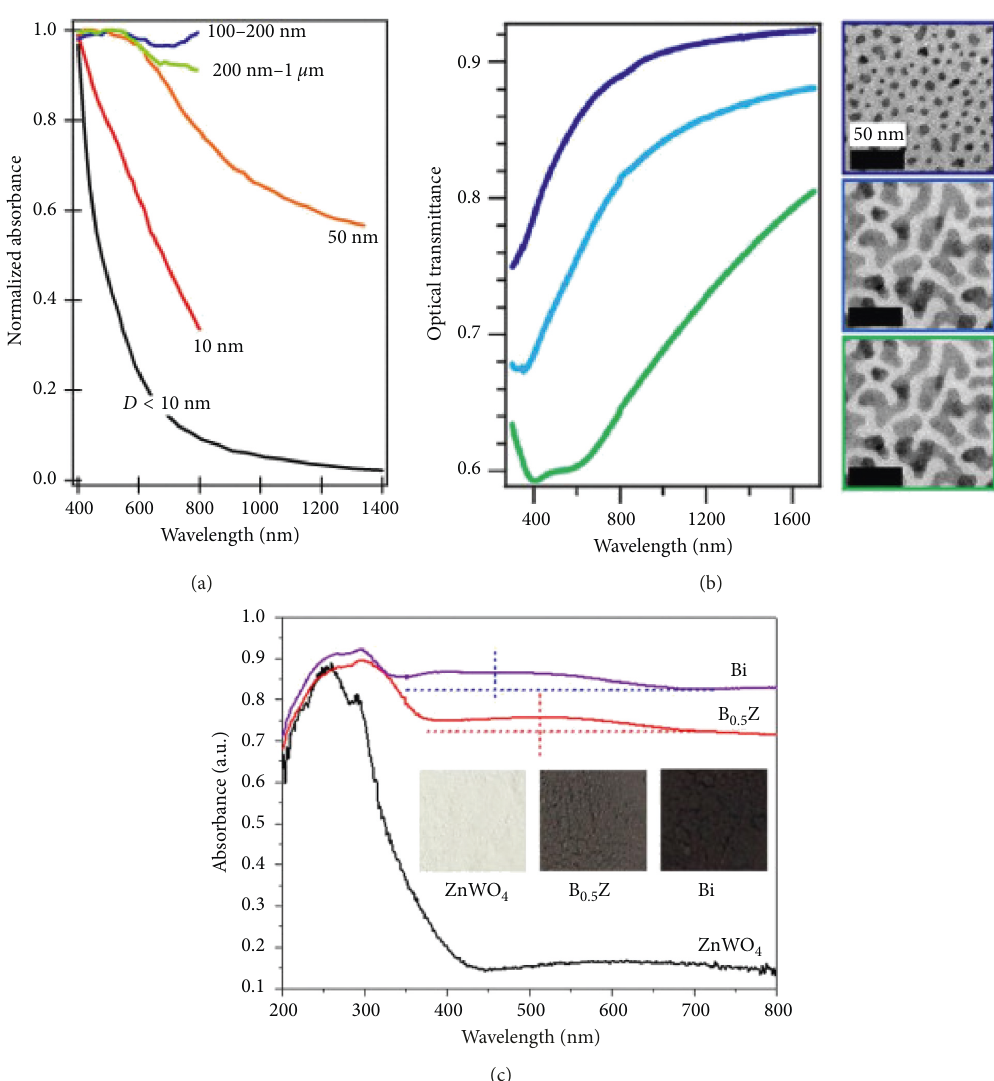
Figure 11: (a) Compilation of experimental absorbance spectra of Bi nanospheres (in liquids) with different diameters taken from the literature: < 10nm [96], 10nm [97], 50nm [54], 100–200nm, and 200nm–1 μ m [99]. (b) Experimental transmittance spectra of assemblies of Bi nanostructures with different sizes and shapes (reprinted with permission from [63] © 2012, American Chemical Society). (c) Experimental absorbance spectra of a ZnWO 4 microsphere, a ZnWO 4 microsphere covered with Bi nanostructures, a Bi film (reprinted with permission from [103] © 2016, American Chemical